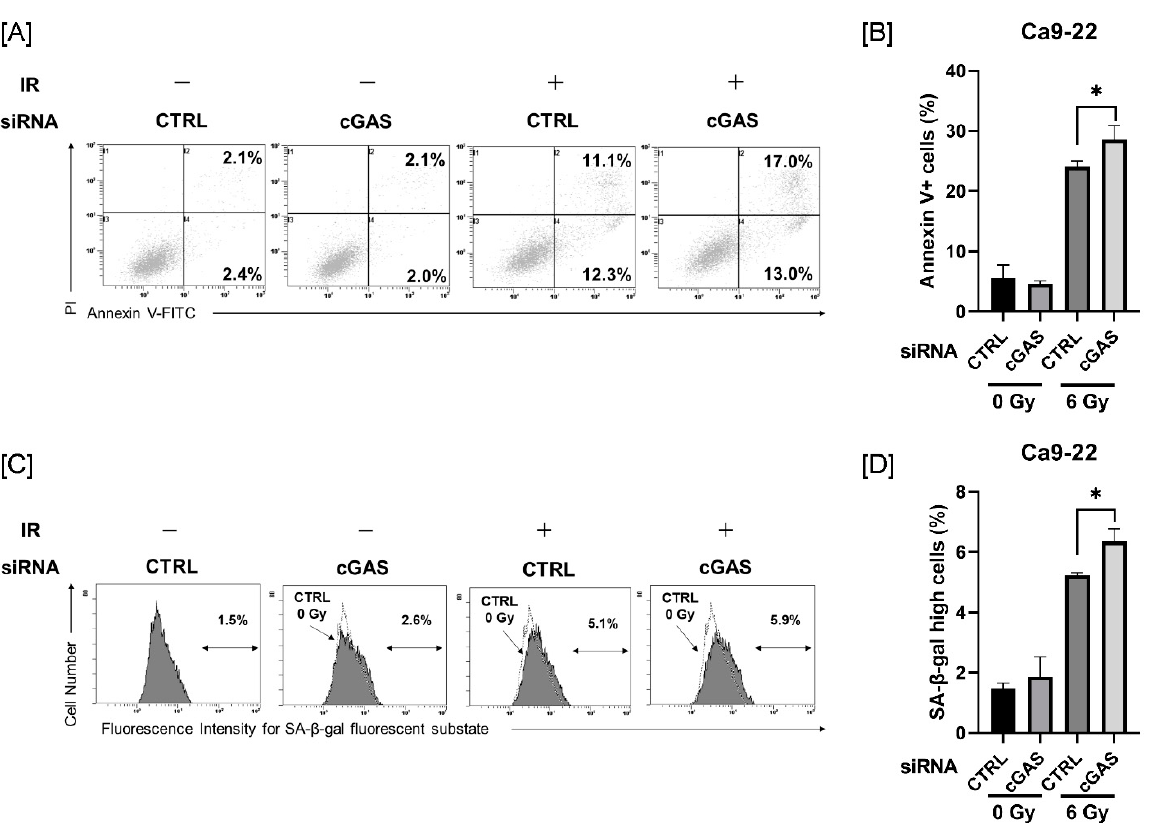
Figure 4. Effect of cGAS knockdown on radiation-induced apoptosis and high SA- β -gal activity in Ca9-22 cells. ( A , B ) cGAS knockdown Ca9-22 cells were irradiated with X-ray. After four days of culture, the analysis of apoptosis was performed. ( A ) Representative cytograms are shown. The inset numbers indicate the percentage of annexin V + /PI − cells or annexin V + /PI + cells. ( B ) The annexin V + apoptotic cells induced by 6 Gy is shown. ( C , D ) X-irradiated Ca9-22 cells were cultured for four days and SA- β -gal activity was analyzed using the senescence β -Galactosidase Activity Assay Kit. Representative histograms of SA- β -gal activity in Ca9-22 cells are shown. The dotted line shows the results of non-irradiated cells, and the inset numbers show the percentage of cells with high SA- β -gal activity. ( D ) The percentage of SA- β -gal high-activity cells is shown. * indicates p < 0.05.